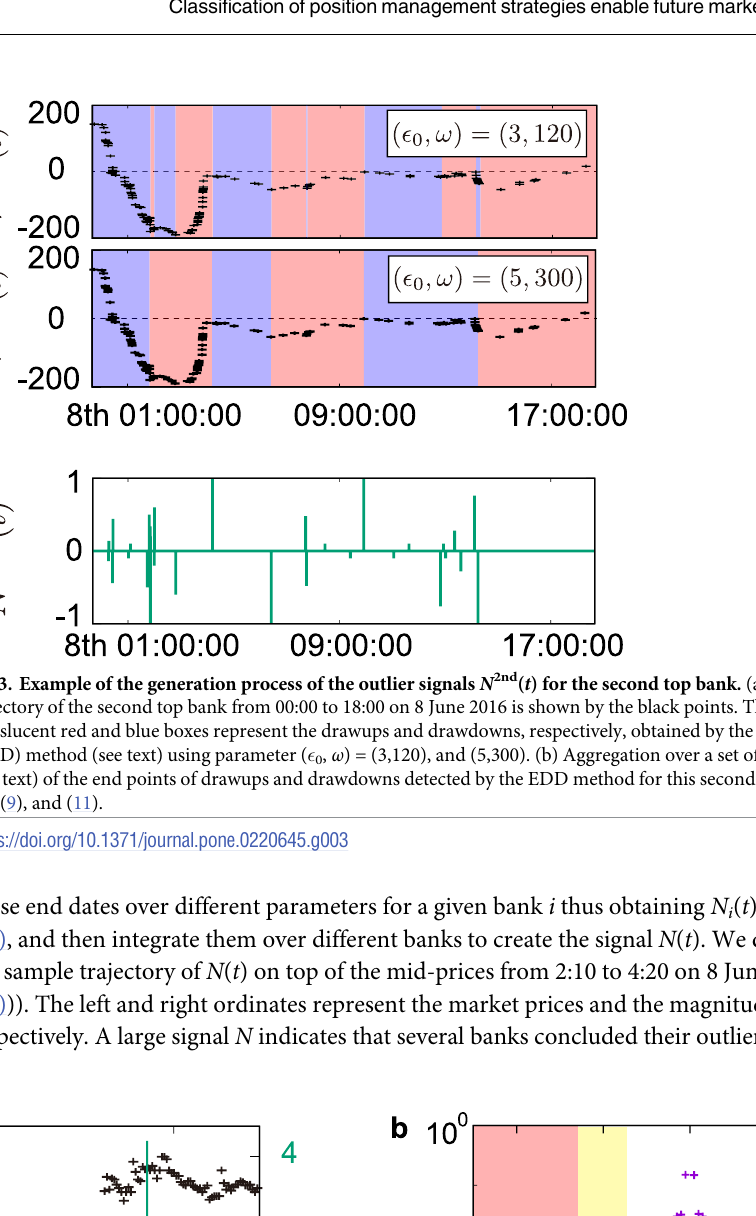
those end dates over different parameters for a given bank i thus obtaining N 3(a), and then integrate them over different banks to create the signal N ( t ). We depict a slice of the sample trajectory of N ( t ) on top of the mid-prices from 2:10 to 4:20 on 8 June 2016 (Fig 4(a))). The left and right ordinates represent the market prices and the magnitude of signal N , respectively. A large signal N indicates that several banks concluded their outlier trades at the